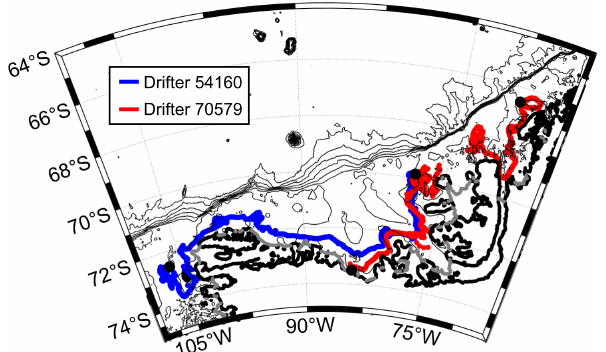
Figure 11. Drifter tracks for two drifters released as part of the Long Term Ecological Research (LTER) program and offering additional support that the AACC provides a connection between the WAP and the Amundsen Sea. Drifter 54160 was released on 1 January 2007 and recorded positions through 24 December 2007. Drifter 70579 recorded positions between 27 January and 24 November 2007; there is a gap in the data for this drifter during 18–27 May (around 74 ◦ W). Large black dots indicate the beginning and end of each drifter